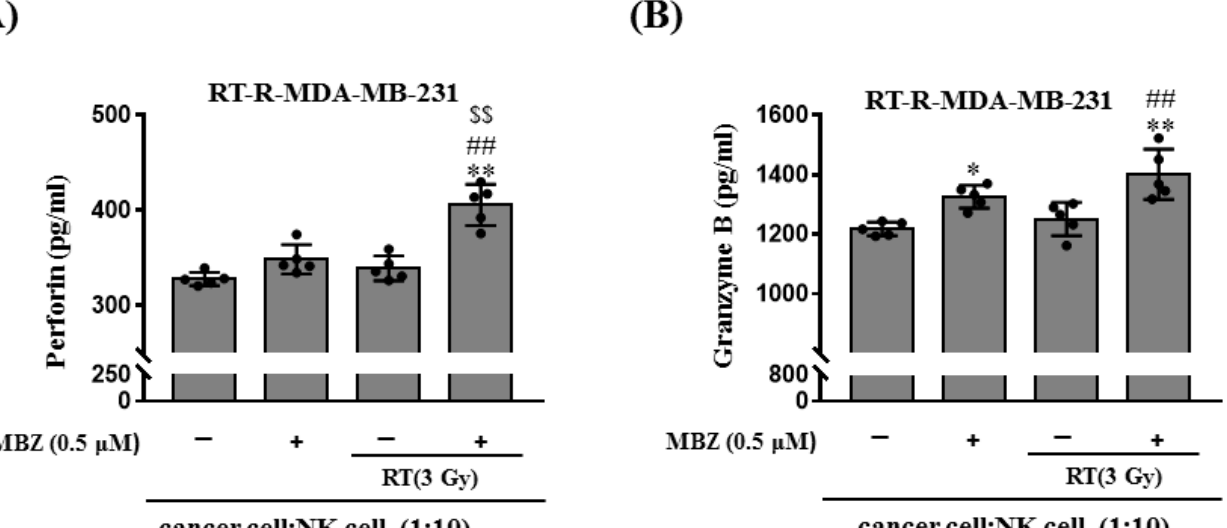
Figure 6. The combination of mebendazole (MBZ) and radiotherapy (RT) significantly increases NK cell-mediated cytotoxicity against RT resistant (RT-R)-MDA-MB-231 cells. ( A ) RT-R-MDA-MB-231 cells (5 × 10 3 cells/60 μ L) were seeded in round-bottom 96-well plates, and NK-92MI cells were added at the indicated ratios (1:1, 1:5, 1:10, and 1:20). After co-incubation for 4 h, LDH was measured in cell supernatants. ( B ) RT-R-MDA-MB-231 cells were treated with MBZ (0.1, 0.5, and 1 μ M) for 24 h, and the cells were collected and seeded in a round-bottom 96-well plate (5 × 10 3 cells/60 μ L/well). Next, NK-92MI cells (1:10 ratio) were added to the 96-well plate, co-incubated for 4 h, and LDH was measured in the cell supernatant as described in the Methods. ( C ) RT-R-MDA-MB-231 cells were treated with MBZ (0.5 µ M) for 1 h and then irradiated with a 3Gy dose of X-rays. After 24 h, the cells (5 × 10 3 cells/60 µ L) were seeded in a round-bottom 96-well plate, and NK-92MI cells (1:10 ratio) were added. After co-incubation for 4 h, LDH was measured in the cell supernatant as described above. The values are presented as the mean ± SD (* p < 0.05, ** p < 0.01 compared with the control; ## p < 0.01 compared with the control of RT 3 Gy).